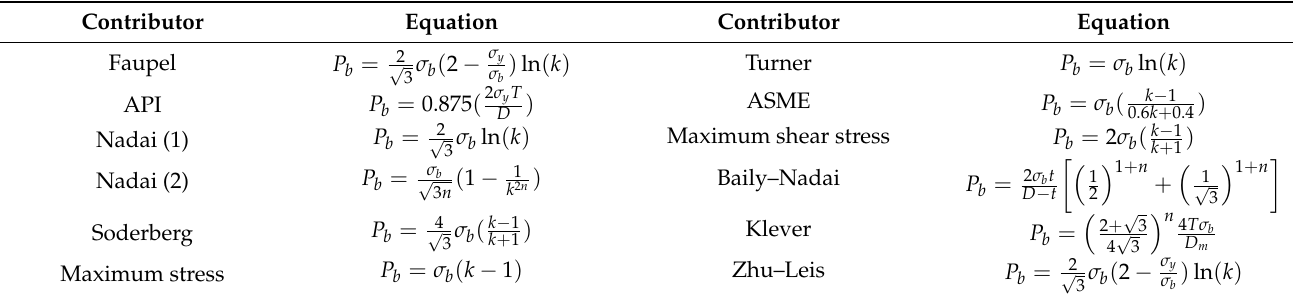
Table 1. Representative predictive formulae for blast pressure ( P b ), reproduced from [26], with permission from Else- vier,